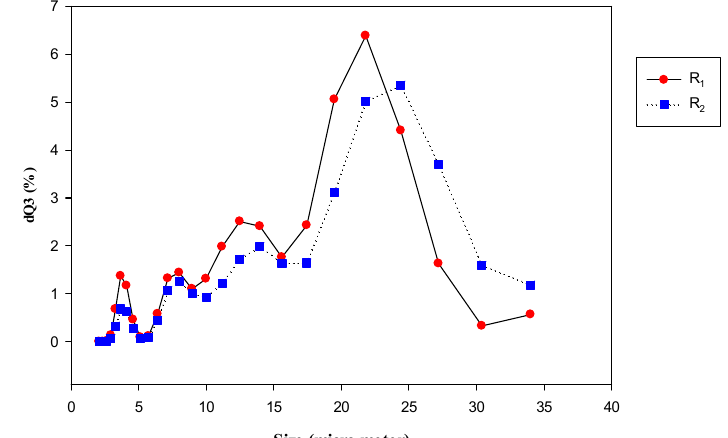
Fig. 8. Particle size distribution (PSD) analysis Fig. 9